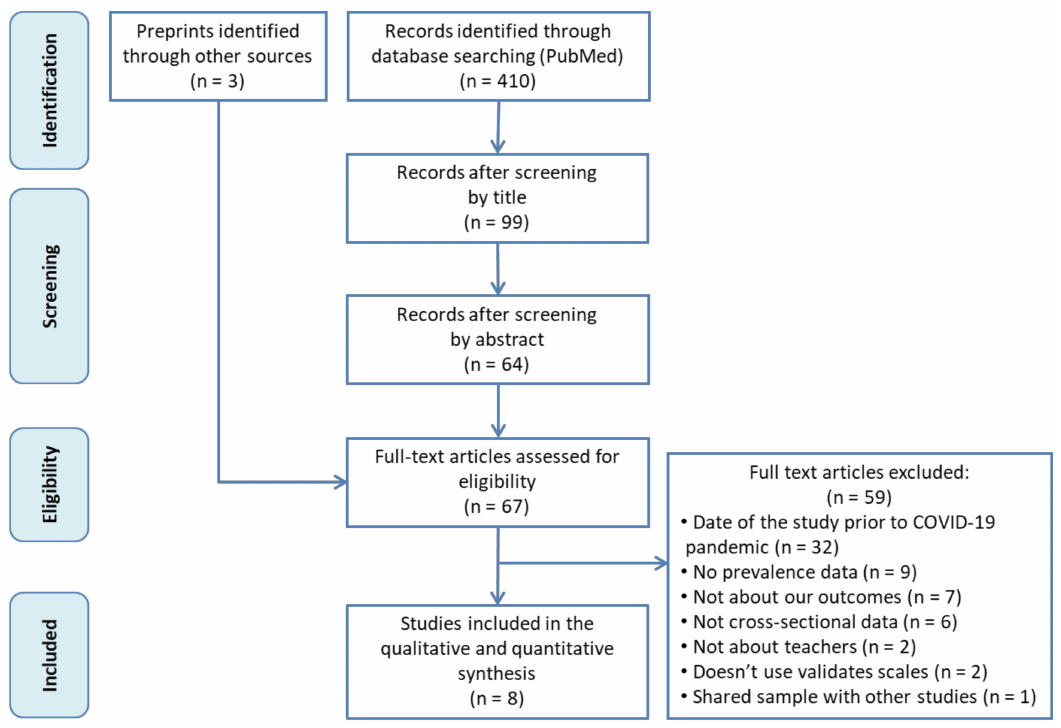
Figure 1. Flowchart of the study search and selection process.